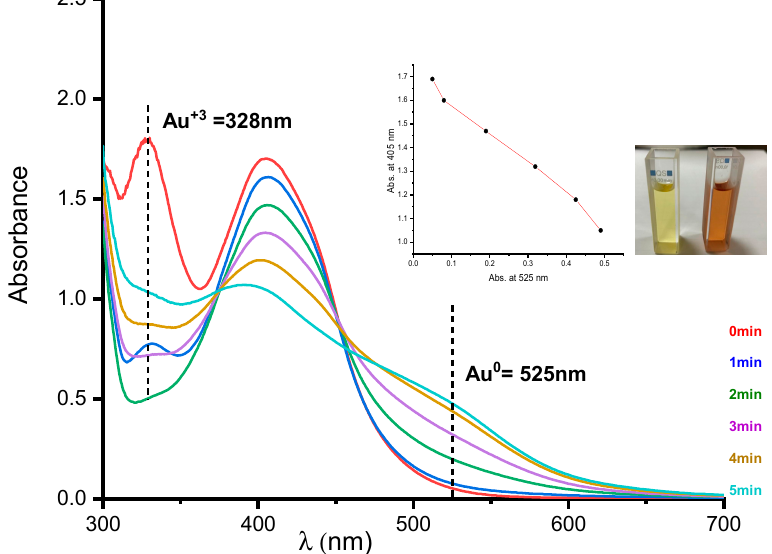
Figure 4. Evolution of the absorption spectra of irradiated mixtures ( λ irr = 419 nm). Solution: HLCuCl 0.05 wt% gold chloride 4wt% and iodonium salt 1 wt% dissolved in 25 mL of DMF.